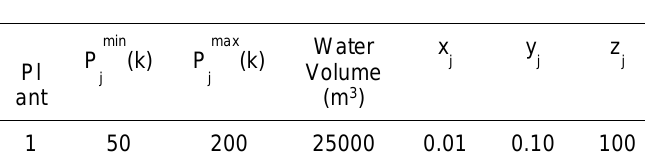
Table 3. Generation cost for hydro units